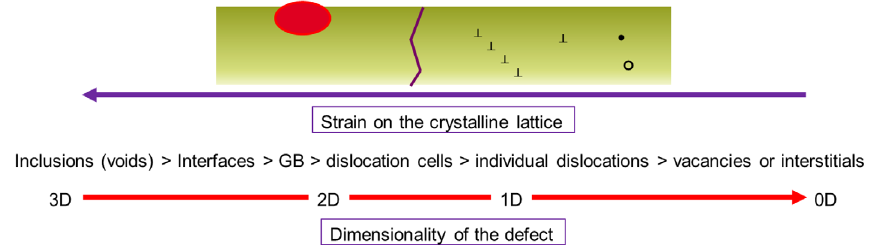
FIG. 1. Typical defects found in crystalline structures. The strain increases with dimensionality of defects; it affects atomic diffusion behavior and local SC properties like ξ or mean-free path as well (see text below for more